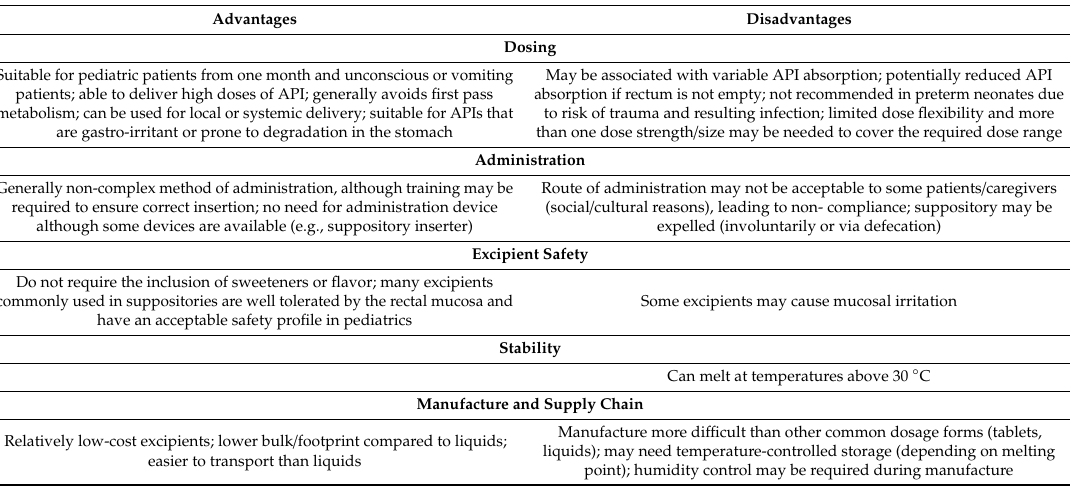
Table 4. Advantages and disadvantages of